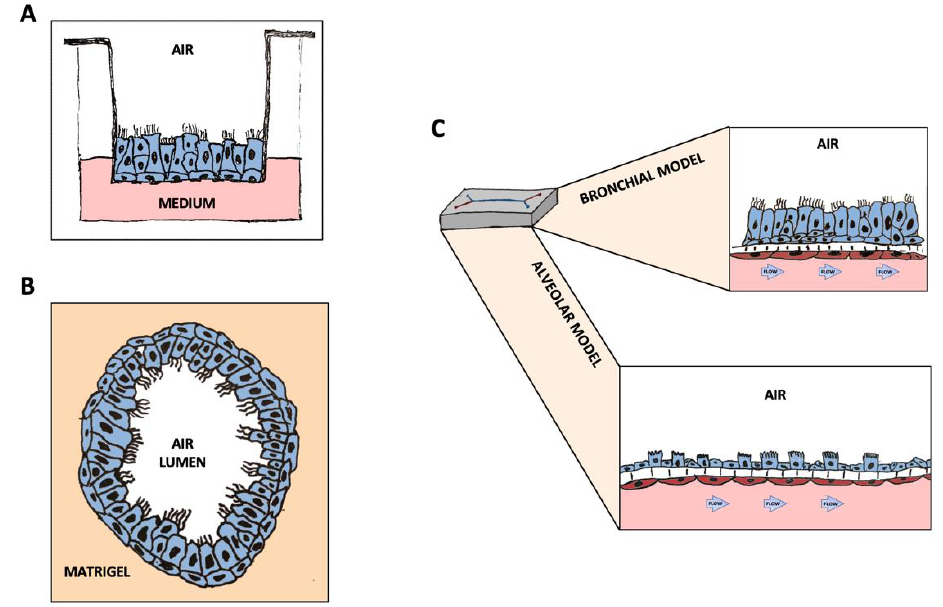
Figure 1. Graphic representation of the 3D structures discussed in this manuscript: ( A ) Airway Epithelial cells in ALI culture on transwells. ( B ) Airway organoids composed of all cell types, differentiated and oriented towards the inner lumen. ( C ) Differentiated lung-airway (top) and lung-alveolus (bottom) chips. The differentiated Airway-on-a-Chip is composed of ciliate, basal, goblet and club cells in the top channel, interfaced with pulmonary microvascular endothelial cells perfused using a microfluidic device. The differentiated alveolus chip is composed of ~45% type II and ~55% type I lung alveolar cells, forming together an in vitro surfactant-producing human alveolar structure.